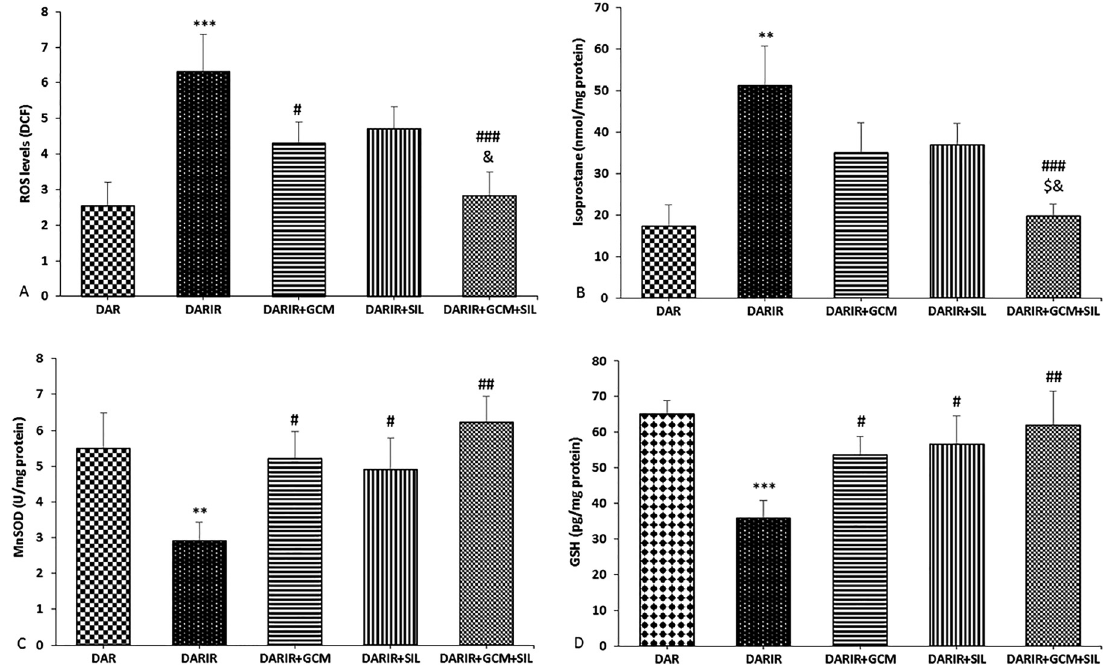
Figure 4: Oxidative/antioxidative markers in liver tissue. (A) ROS production assessed by DCFDA dye; (B), 8-isoprostane; (C) MnSOD; and (D) glutathione or GSH levels. The data was expressed as mean ± SD. N=6 for each group. **p<0.01 and ***p<0.001 as compared with DAR group; #p<0.05, ##p<0.01, and ###p<0.001 as compared with DARIR group. $ p<0.05 and & p<0.05 as compared with DARIR + GCM and DARIR + SIL groups, respectively. DAR, diabetic aged rat; DARIR, diabetic aged rat subjected to ischemia-reperfusion; GCM, ginsenoside compound-Mc1; SIL, silibinin.